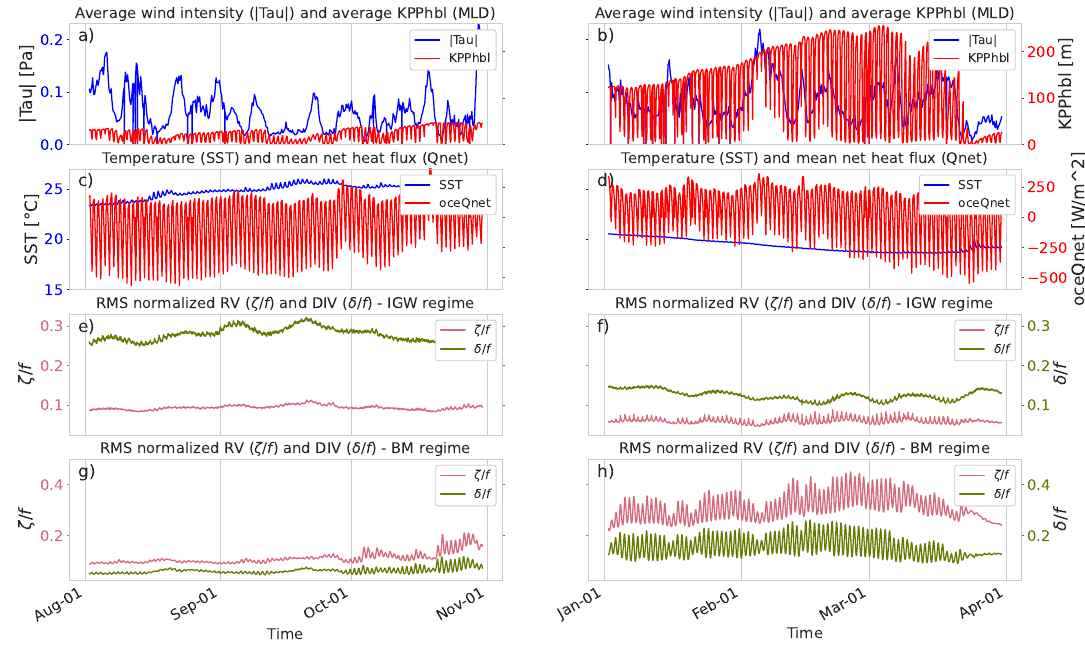
Figure 9. Time series of dynamical variables for the study area centered at 26.6 ◦ N within the Canary current from 2 August to 30 October 2012 ( a , c , e , g ) and from 2 January to 30 March 2012 ( b , d , f , h ) seasons. First row ( a , b ): mean values for the wind stress ( | τ | , blue) and the KPP turbulent boundary layer depth ( KPP hbl , red). Second row ( c , d ): mean values for the sea surface temperature (T, blue) and ocean net heat flux (oceQnet, red). Third row ( e , f ): standard deviation of the normalized vorticity ( ζ / f , magenta) and divergence ( δ / f , green) fields in the internal gravity wave (IGW) regime. Fourth row ( g , h ): standard deviation of the normalized vorticity ( ζ / f , magenta) and divergence ( δ / f , green) fields in the balanced motion (BM)